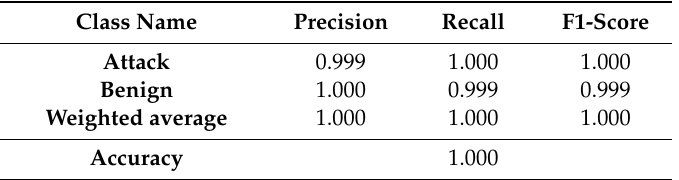
the selected features numbers 13, 28, and 14.